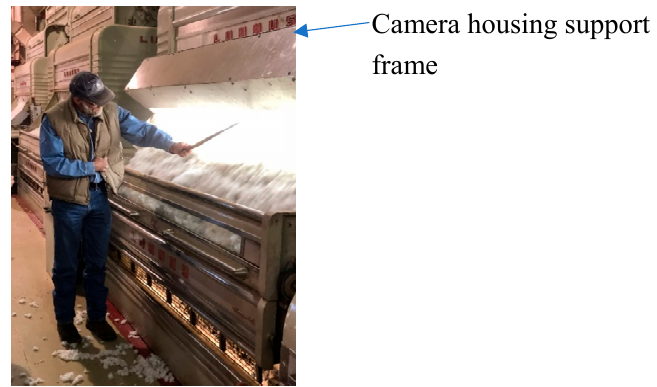
Figure 2. Field testing of the camera detection system in commercial cotton gin.